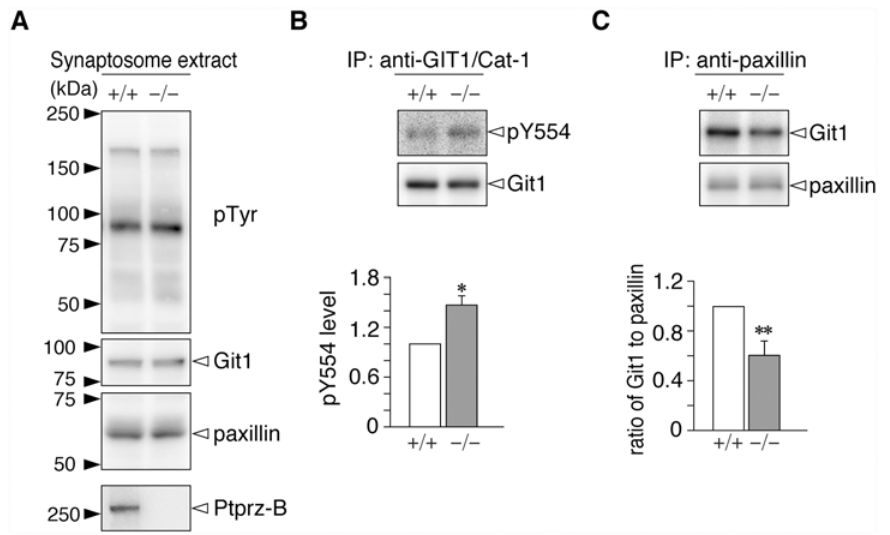
Fig 5. Comparison of Git1 phosphorylation at Tyr-554 and its binding to paxillin between wild-type and Ptprz -deficient mice. A , Western blotting of cerebral synaptosome extracts prepared from the brains of wild-type (+/+) and Ptprz -deficient ( − / − ) mice. The overall tyrosine phosphorylation pattern and protein expression were analyzed with an anti-phosphotyrosine PY20 antibody, and rabbit anti-Git1 and anti-paxillin antibodies, and rabbit anti-Ptprz-S, respectively. The Ptprz-B isoform was previously shown to be detectable after the chondroitinase-ABC treatment [16] because Ptprz proteins are expressed as chondroitin-sulfate proteoglycans in the brain [15]. B , Tyr-554 phosphorylation of Git1. The synaptosome extracts were immunoprecipitated with rabbit anti-GIT1/Cat-1 antisera-coated beads, and the binding proteins were analyzed by Western blotting with rabbit anti-pY554-Git1 and mouse anti-Git1 antibodies. The Tyr-554 phosphorylation level was determined by densitometric analyses. Data are the mean ± S.E. (error bars; n = 5). * , P < 0.05 significantly different from the wild-type by the Student ’ s t -test. C , Git1 binding to paxillin. The immunoprecipitated proteins with mouse anti-paxillin were analyzed by Western blotting with rabbit anti- Git1 and rabbit anti-paxillin antibodies. The amount of Git1 relative to that of paxillin was determined by densitometric analyses. Data are the mean ± S.E. (error bars; n = 6). ** , P < 0.01 significantly different from the wild-type by the Student ’ s t